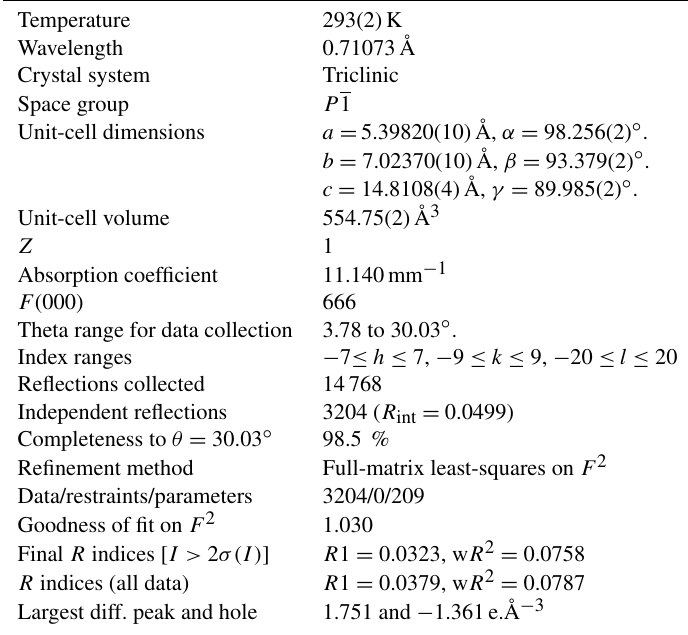
Table 5. Crystal data and experimental conditions for the single-crystal XRD